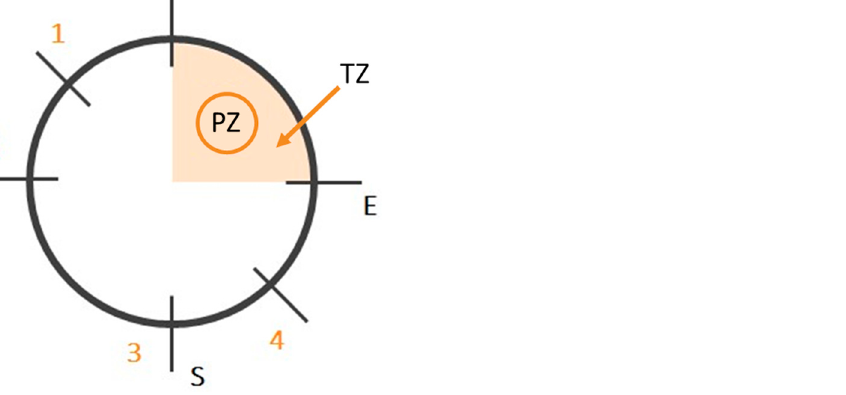
Figure 1. Schematic representation of the Morris water pool. PZ—platform; TZ—the area inside which the platform was located; 1, 2, 3, 4—starting points.